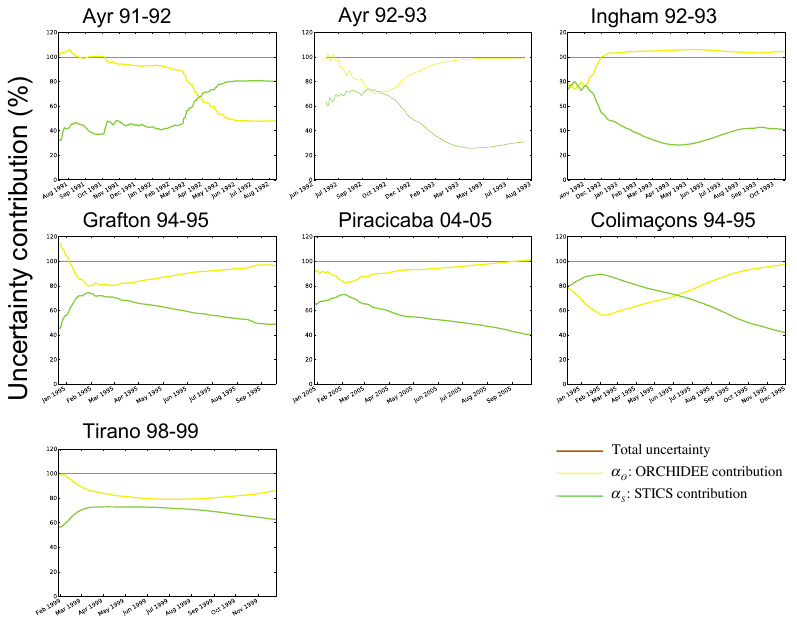
Figure 9. Contribution (%) of ORCHIDEE (yellow) and STICS (green) to the total uncertainty (brown) over the length of the growing season for seven sites after parameter uncertainty ranges have been constrained through optimization at seven